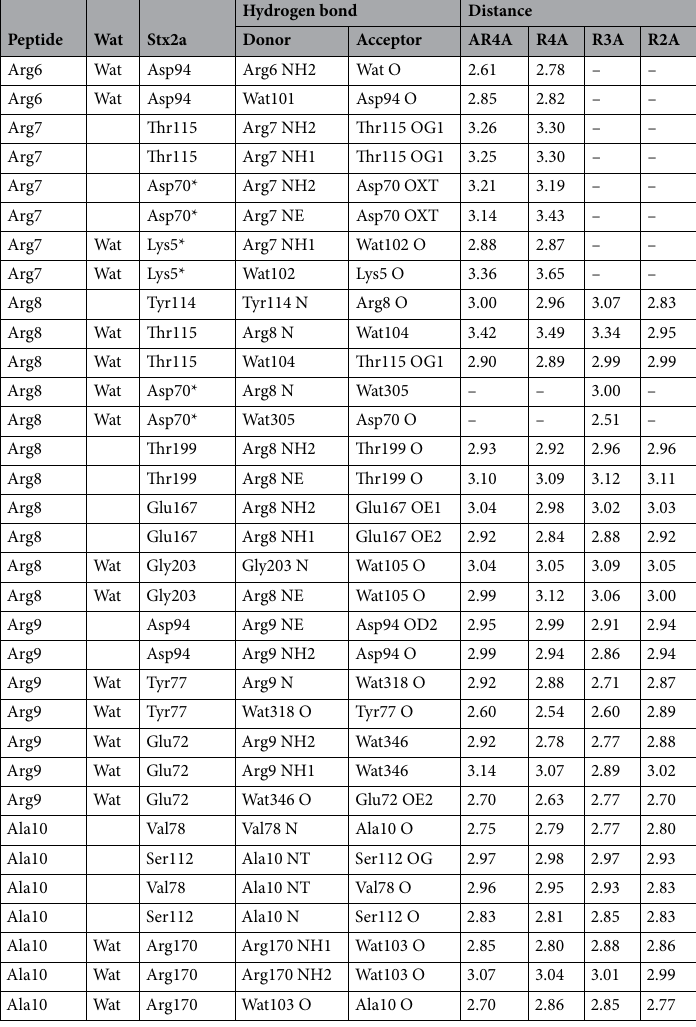
Table 2. Hydrogen bonding interactions between shorter peptides and the Stx2a A-subunit. *Asterisk indicates the residue is in the Stx2a